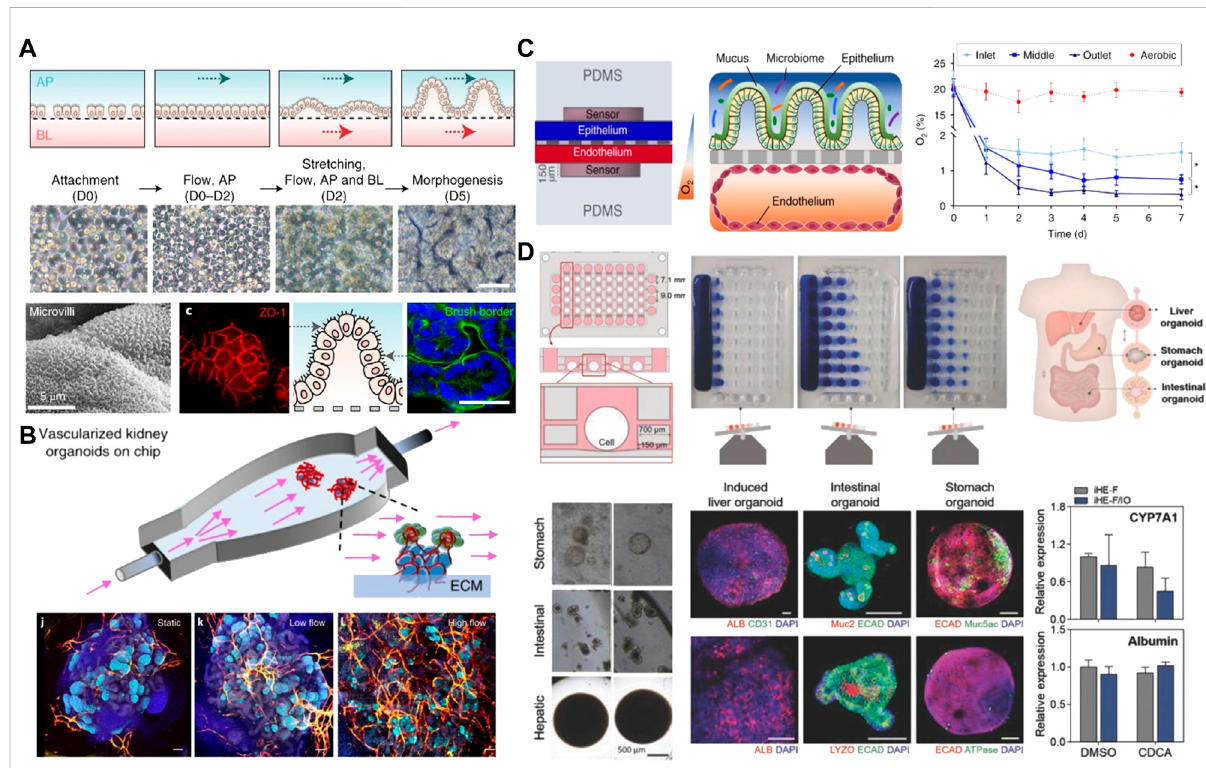
FIGURE 4 Advanced micro fl uidic-based platforms for mimicking better morphogenesis and the establishment of a multiorgan model. (A) Establishment of Intestinal morphogenesis in a gut-on-a-chip under both apical fl ow and basolateral fl ow and mechanical stretching after 5 days of culture. The culture epithelium showed the microvilli architecture and the formation of tight junctions. Adapted from ref. (Shin and Kim, 2022). (B) Vascularized kidney organoids culture within a perfusable chip under fl uid fl ow and the in fl uence of different fl ow conditions including static, low and high fl ow on vascularization. Adapted from ref. (Homan et al., 2019). (C) Two-channels intestine-on-a-chip with an oxygen gradient and oxygen concentration pro fi les between an aerobically-cultured endothelium channel and an anaerobically-cultured epithelium channel. Adapted from ref. (Jalili-Firoozinezhad et al., 2019). (D) A micro fl uidic-based multiorgan model of liver, small intestine, and stomach organoids in a microplate array format on the rocking culture system. Immunostaining analysis of speci fi c markers for three different tissues and valid interorgan